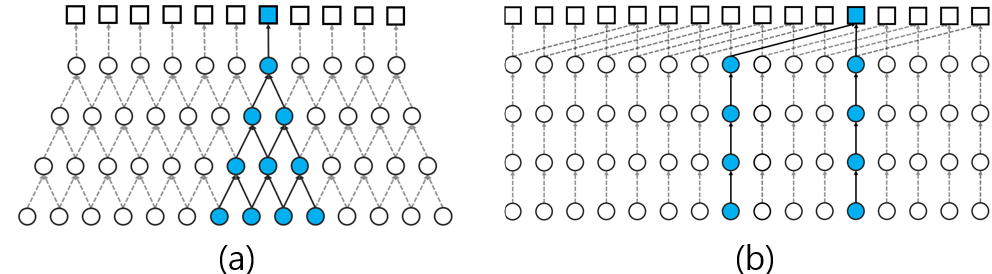
Figure 3. Difference between standard CNN and causal CNN. ( a ) Standard CNN; ( b ) Causal CNN (Note: Blue denotes the number of nodes needed in current operation).